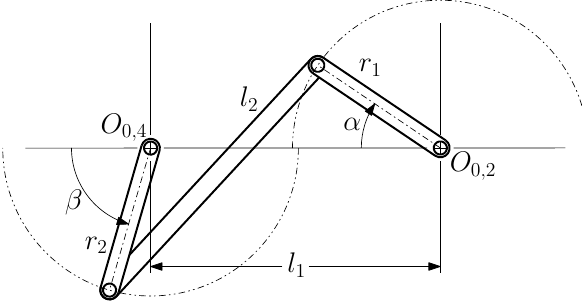
Figure 3. Linkage connecting the metacarpals of the index and ring